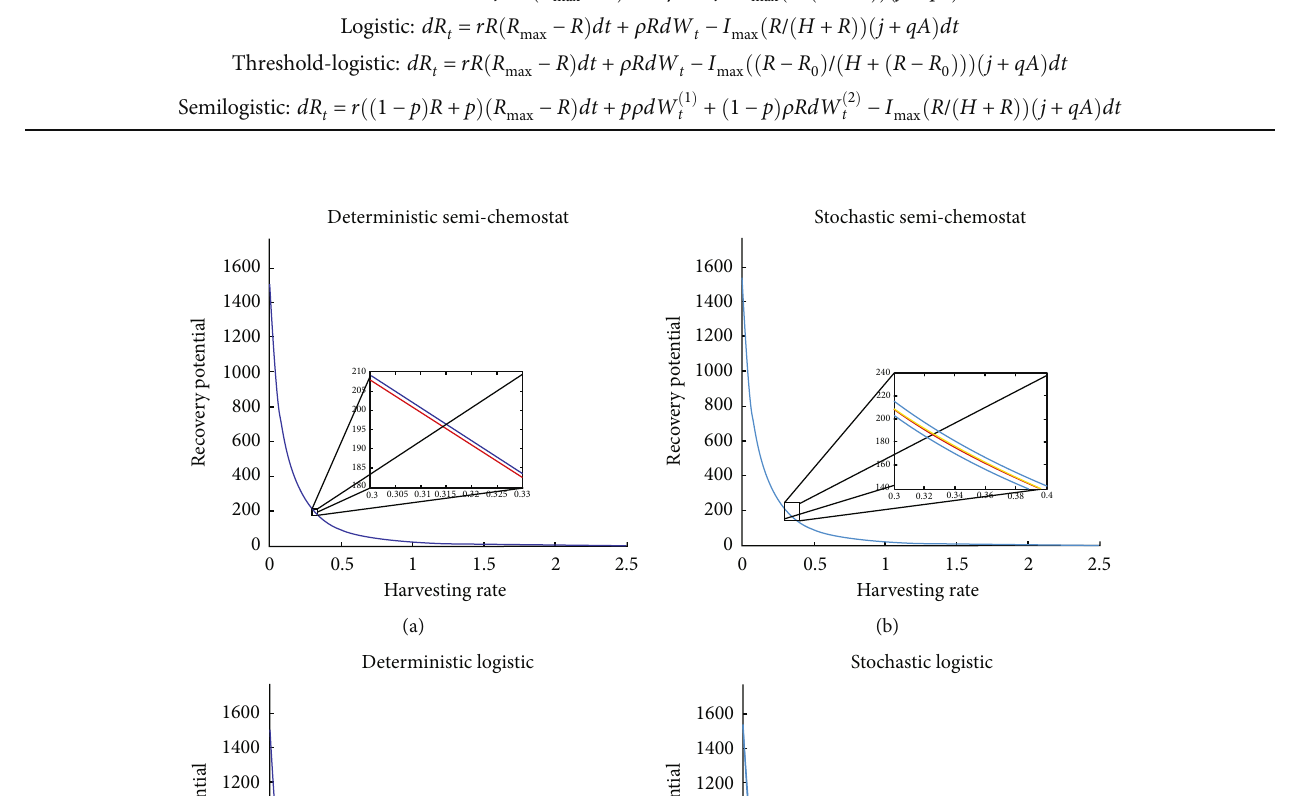
Table 1: Summary of resource dynamic models in stochastic setting including consumption from population. The deterministic resource dynamics are given by analogous equations, where terms involving dW are excluded; that is, we set the volatility ρ = 0 . − R ð Semichemostat: dR = r R max t